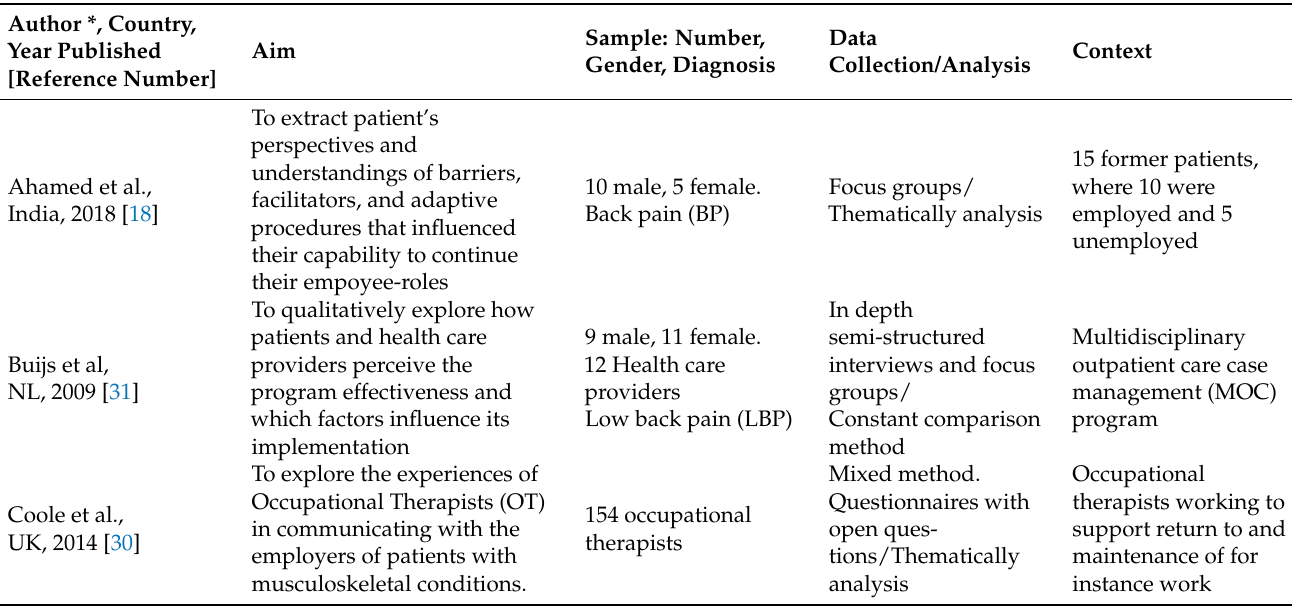
Table 2. Summary of characteristics of included